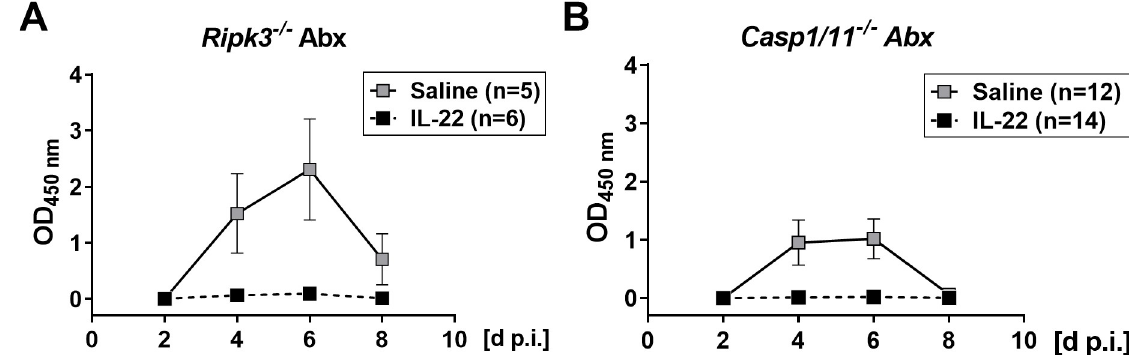
Fig 5. No role for RIPK3-induced necroptosis or caspase 1-mediated death in IL-22-mediated clearance of rotavirus from antibiotic- treated mice. Antibiotic-treated Ripk3 -/- (A) and Casp1/11 -/- (B) mice were treated with saline or IL-22 and infected with rotavirus strain EDIM as in the experiment described in Fig 3D. Viral antigen levels in fecal samples were analyzed by ELISA. Numbers of animals in each group are indicated. Symbols represent means ± SEM.